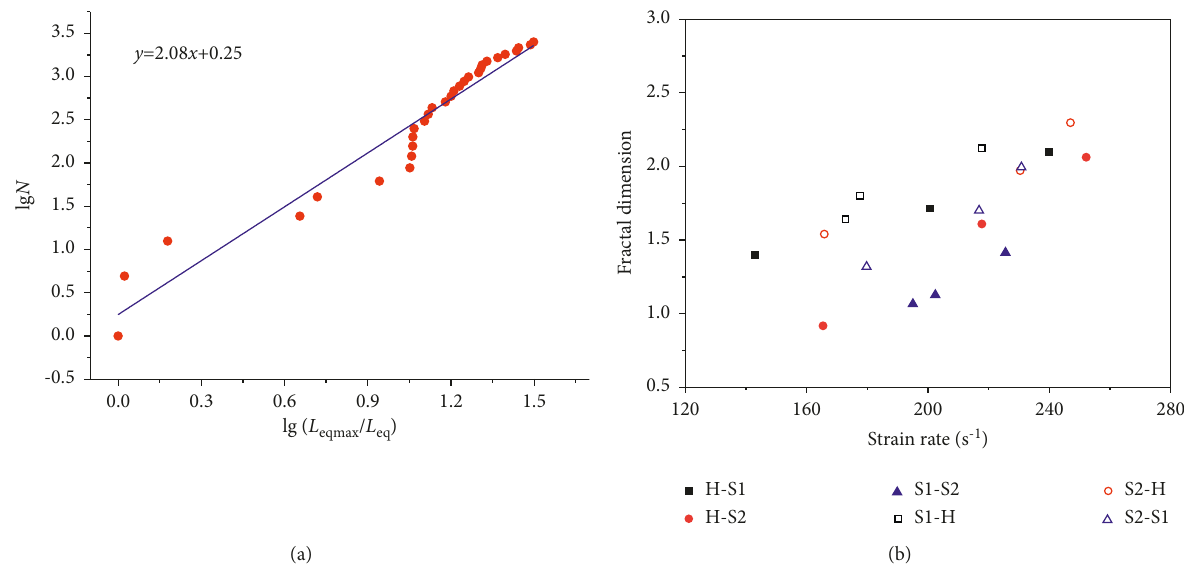
Figure 14: (a) Diagram of fractal dimension calculation, and (b) variations of fractal dimension of different composite samples with strain rate.